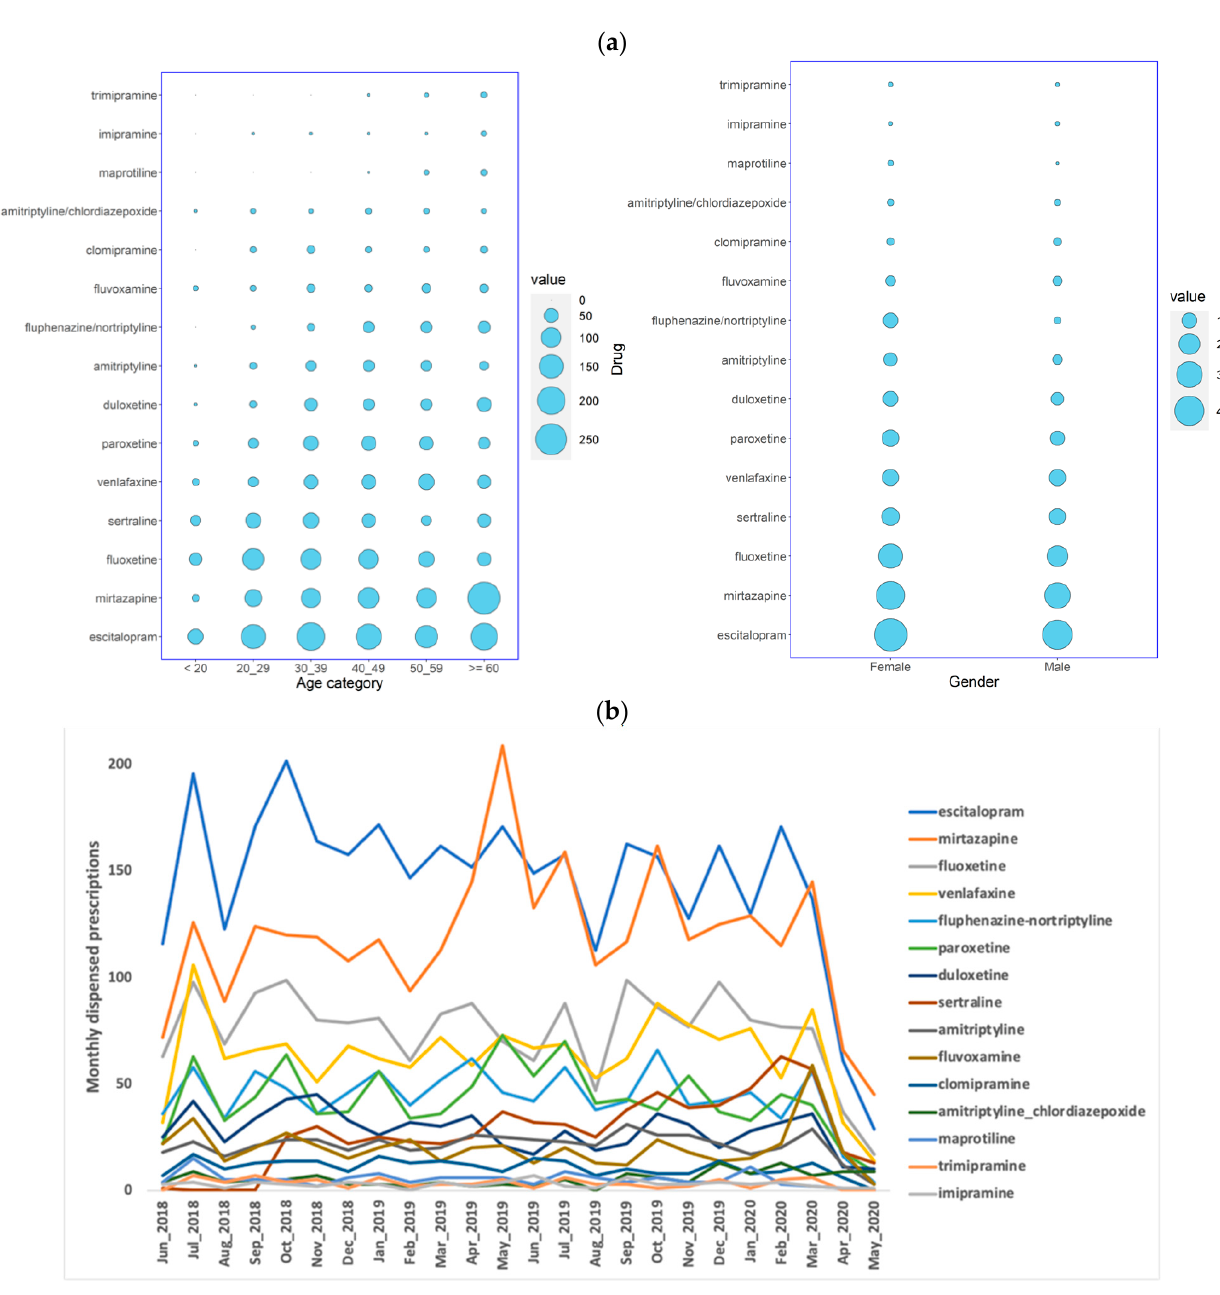
Figure 5. ( a ) The distribution of the number of Qatari patients receiving prescriptions of antidepressants over a period of 2 years in the Mental Health Hospital alone, stratified by age or gender, and ( b ) the number of prescriptions of antidepressants dispensed over a period of 2 years in the Mental Health Hospital alone, with the number of prescriptions dispensed monthly on the Y -axis, and the months on the X -axis.